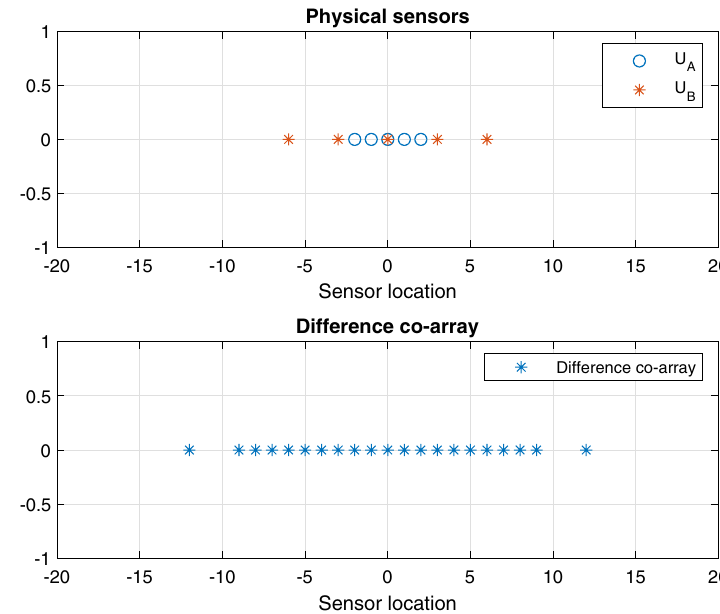
Fig. 1 Sparse convolutional array of (3, 3)